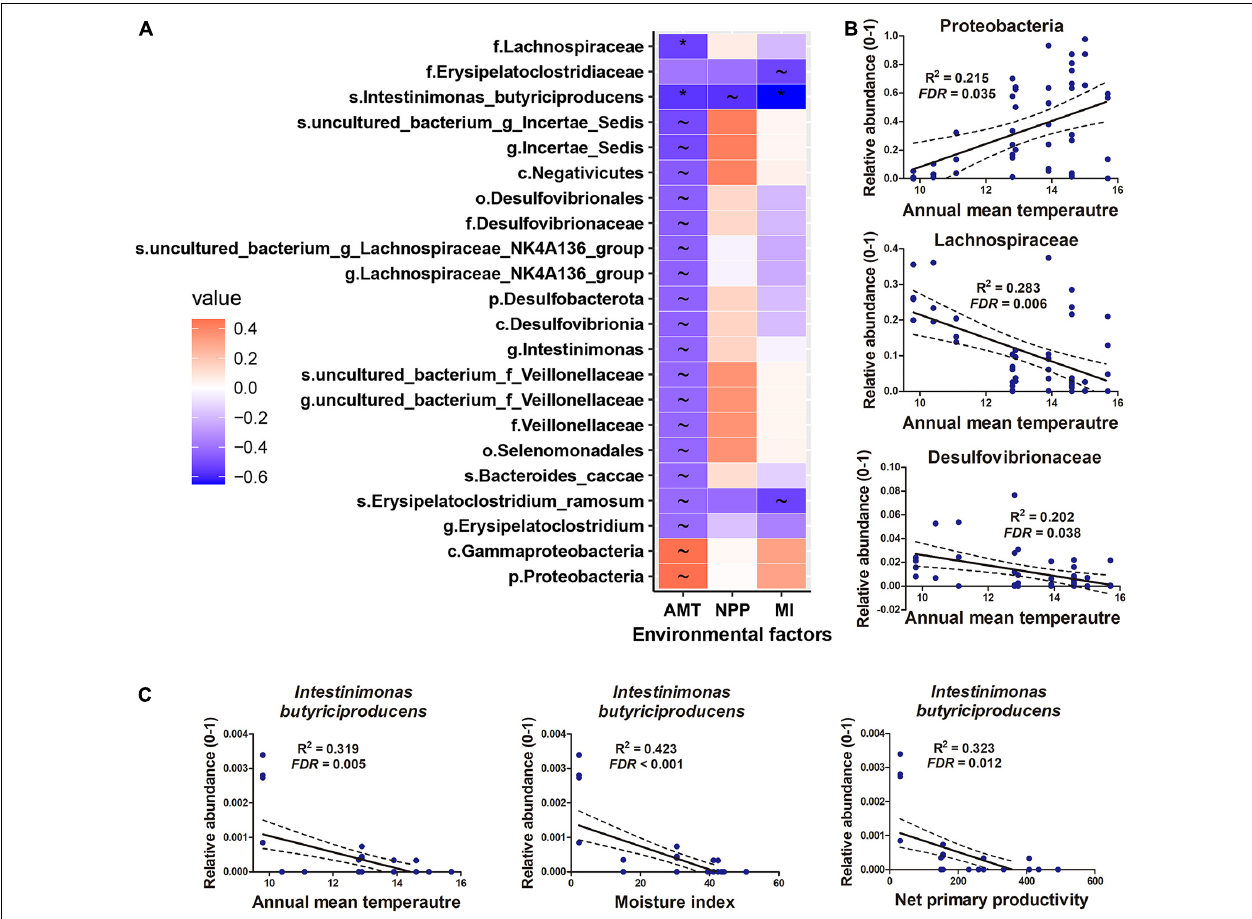
FIGURE 5 | Gut microbiomes associated with climatic factors. (A) Heatmap presenting the correlations ( R -value) between gut microbes and climatic factors. Climatic factors were limited to those contributing significantly to the variations in the gut microbiome ( p < 0.05, PERMANOVA). * q < 0.01 for Pearson correlation and p < 0.05 for Spearman correlation; ∼ q < 0.05 for Pearson correlation and p < 0.05 for Spearman correlation. (B,C) Correlations between microbes and environmental